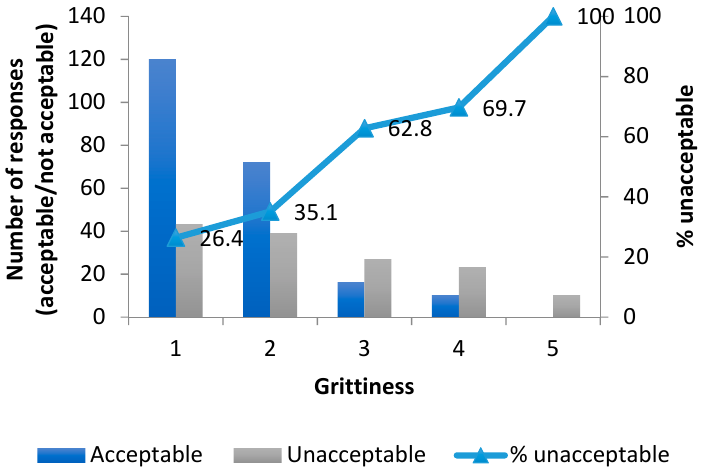
Figure 6. Cumulative frequency of unacceptability as a medicine with grittiness for all 360 evalua- tions.